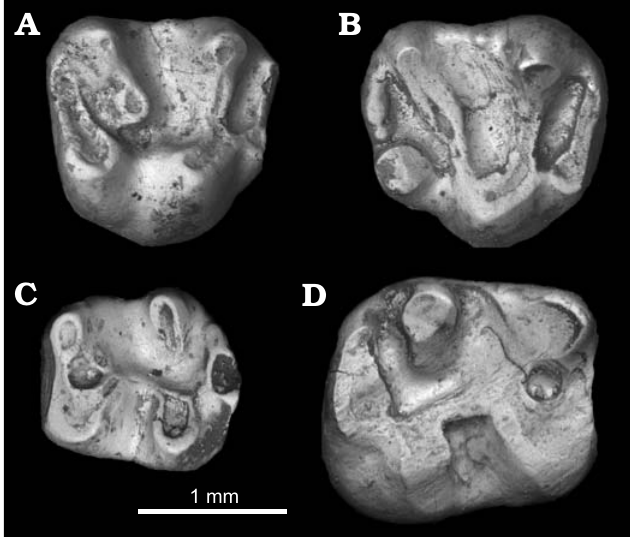
Fig. 13. Ctenodactyloid rodent Gobiomys exiguus Wang, 2001 from the Eocene of Wulanhuxiu, Nei Mongol, China. A . Right M2 (IVPP V20827.1). B . Right M3 (IVPP V20827.2). C . Left m1 (IVPP V20827.3). D . Right m2 (IVPP V20827.4). All in occlusal